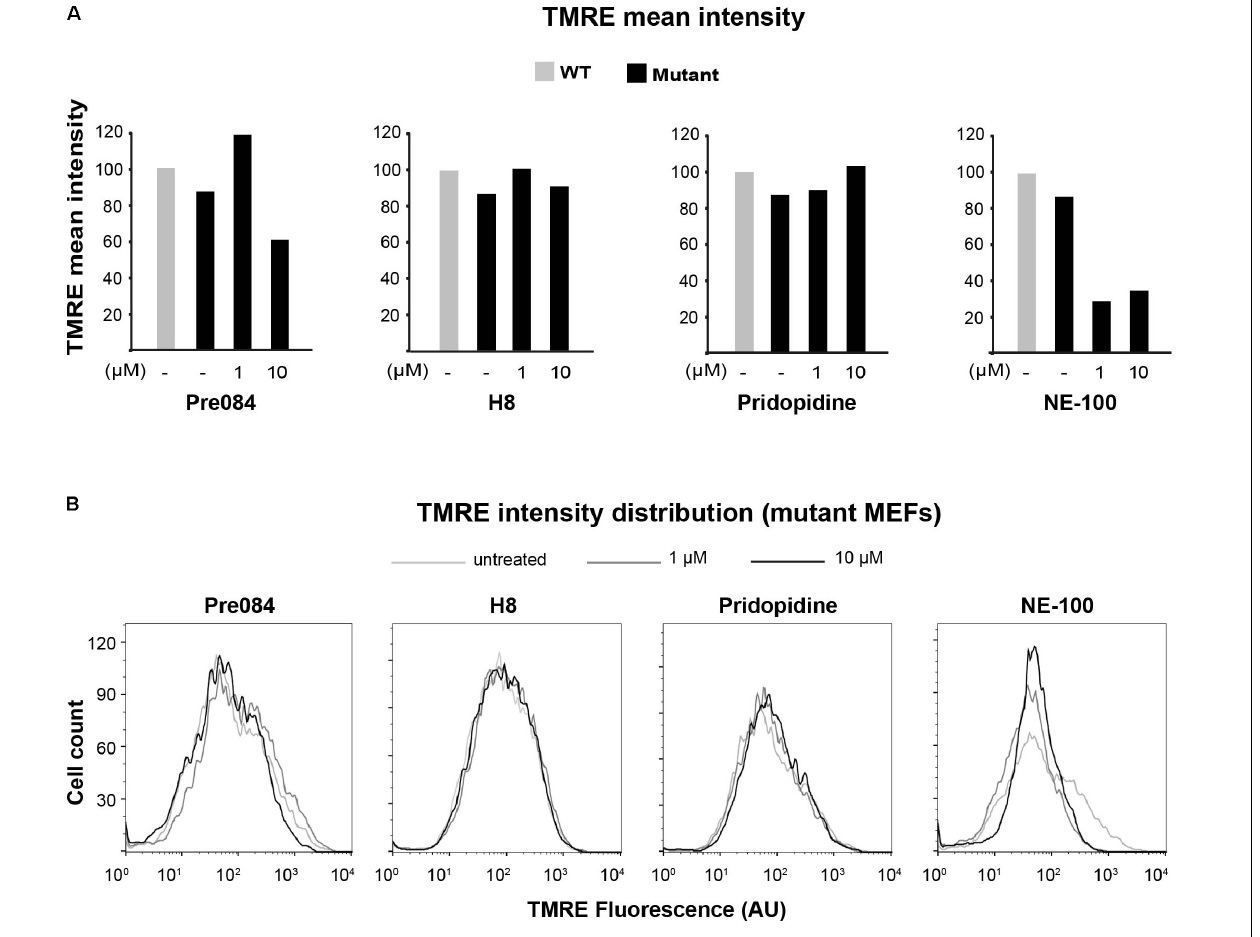
FIGURE 6 | Effect of S1R binders on mitochondria membrane potential in mutant MEFs. Flow cytometry analysis of WT and Mut MEFs incubated or not with the indicated compounds for 6 h and stained with TMRE. Shown is TMRE mean intensity (A) and TMRE intensity distribution (B) of a representative